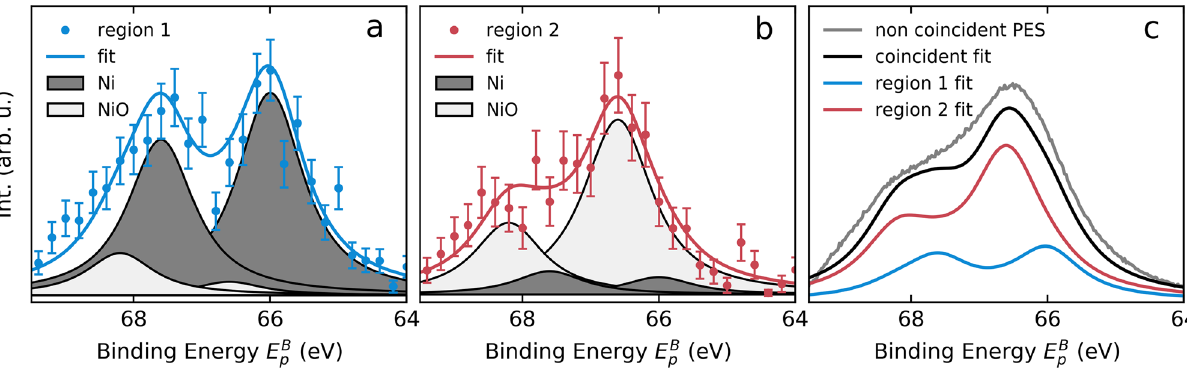
Figure 3. Ni 3 p spectra in coincidence with different MVV Auger electron regions. ( a ) 3 p spectrum in coincidence with the lower kinetic energy Auger region (Fig. 2b blue square). The final fit is shown as a solid blue line and contains the spin–orbit split 3 p 3 / 2 and 3 p 1 / 2 peaks from bulk Ni in dark gray and the spin–orbit split 3 p 3 / 2 and 3 p 1 / 2 contribution from the Ni surface in light gray. ( b ) 3 p spectrum in coincidence with the higher kinetic energy Auger region (Fig. 2b red square). The final fit containing the same components as in ( a ) is shown as a solid red line. ( c ) In gray the non-coincidence PES Ni 3 p measurement is shown together with a weighted sum (black) of the fits from ( a ) (blue) and ( b ) (red). The figure was created using the python matplotlib package 53